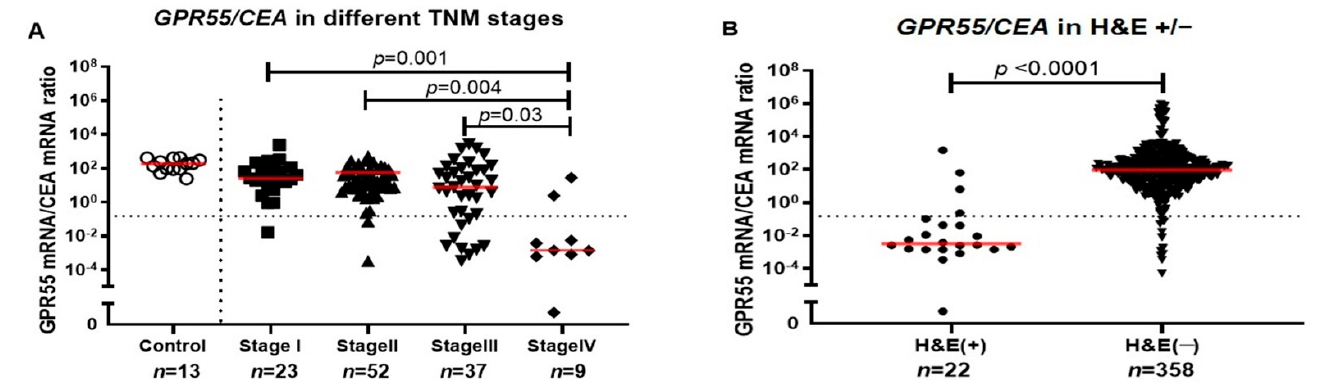
Figure 2. ( A ) GPR55/CEA mRNA ratio in lymph nodes from non-cancerous disease patients (control) and colon cancer patients in different TNM stages (Stage I–IV). ( B ) GPR55/CEA mRNA ratio in metastatic (H&E(+)) and non-metastatic (H&E( − )) lymph nodes. Red horizontal lines indicate median values. Dashed horizontal line shows clinical cutoff equal to 0.1481 GPR55 mRNA/CEA mRNA ratio and ( n ) number of lymph nodes. p -Values were calculated by Kruskal–Wallis non-parametric ANOVA, followed by post hoc Dunn’s test for multiple comparisons in ( A ) and by two-tailed Mann–Whitney test for comparison between expression levels in ( B ).